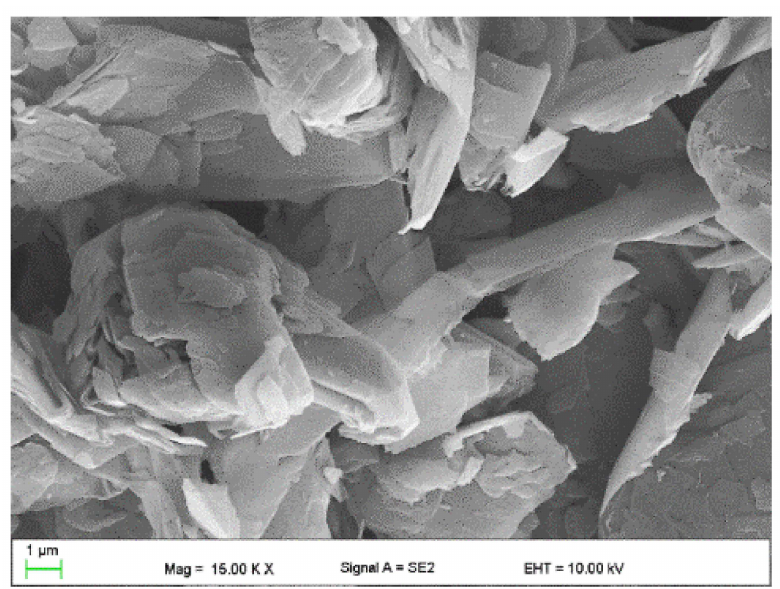
Figure 3. Graphite